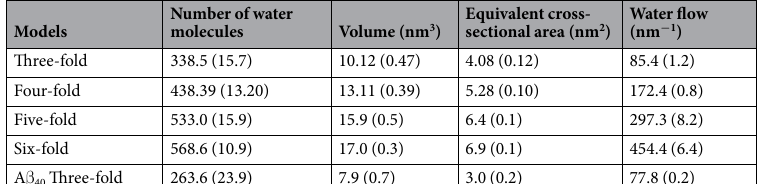
Table 4. Average number of water molecules in pores and the equivalent cross-sectional area as measured in our A β 11–42 fibril